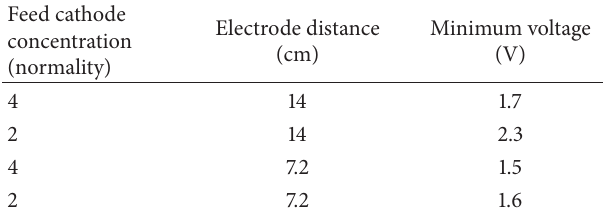
Table 3: Minimum voltage required for different feed concentra- tions.